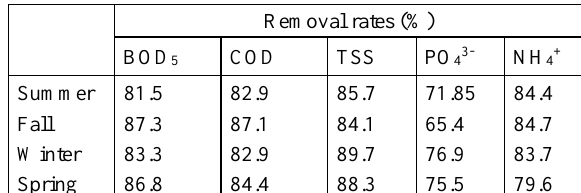
Table 3. ANOVA test of organic matter between influent and effluent at p <0.05